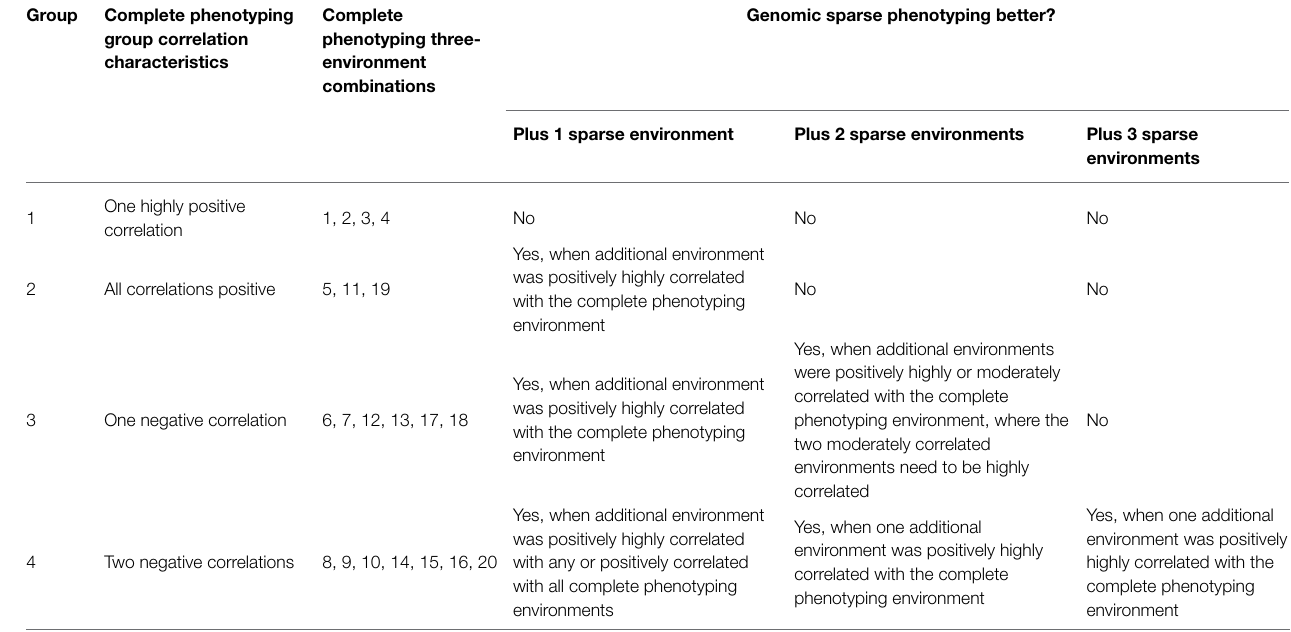
TABLE 1 | Wheat – grouping of 3-environment combinations according to their utility of genomics-assisted sparse phenotyping over complete phenotyping. Group Complete phenotyping group correlation